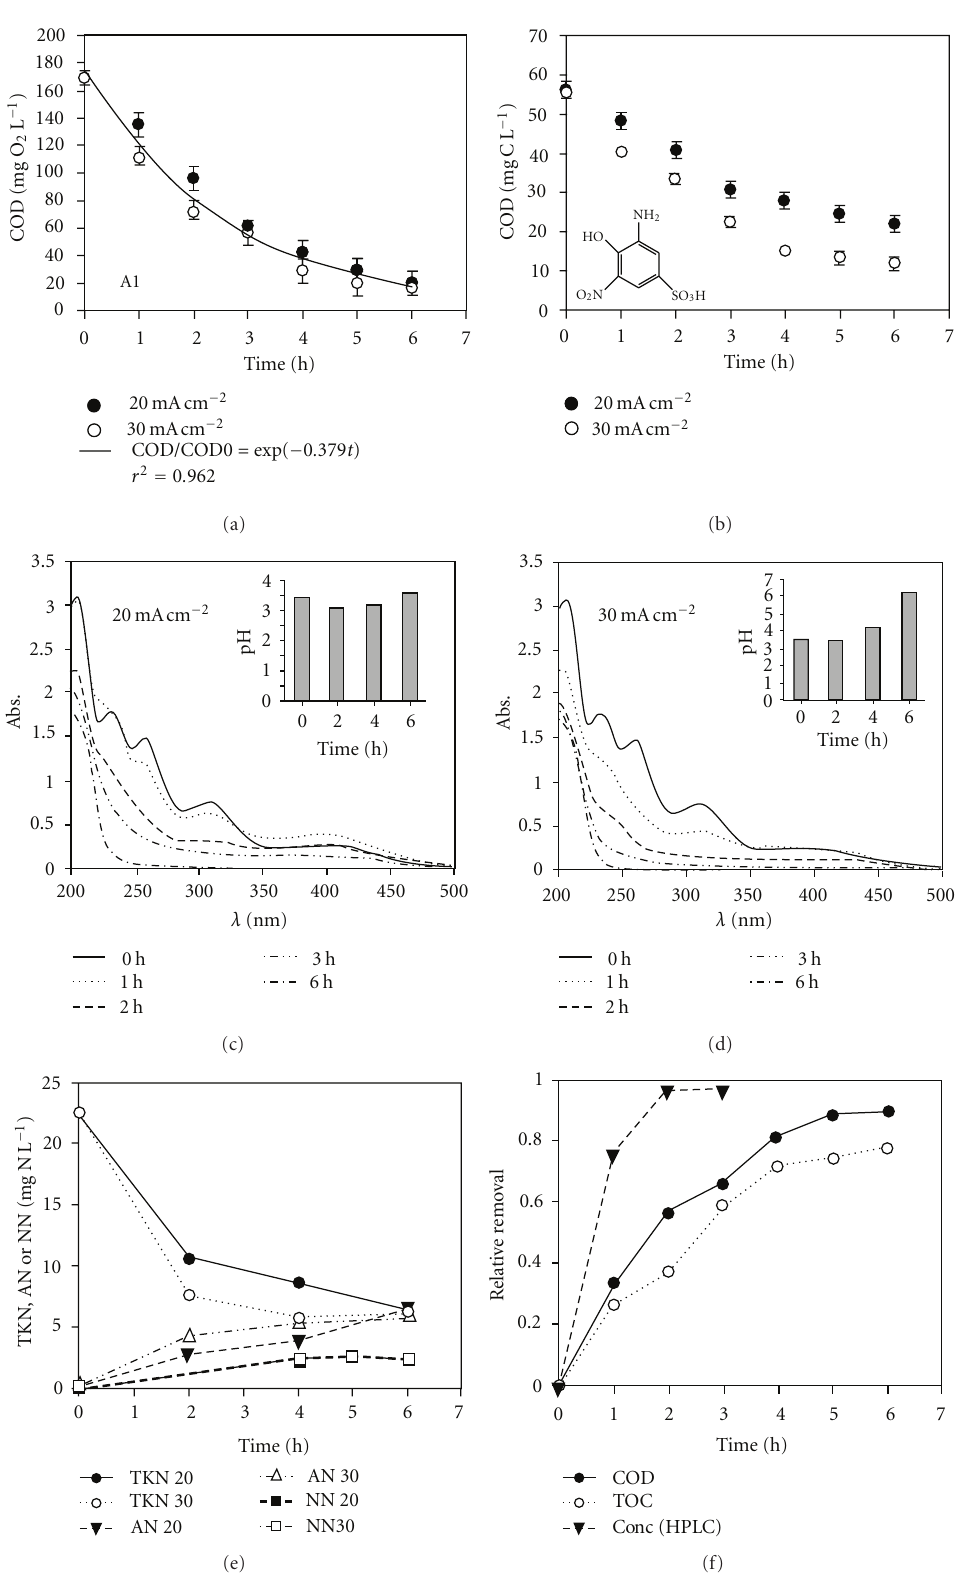
Figure 8: Variations of COD (a), TOC (b), absorbance and pH (c, d), TKN, AN and NN (e) and relative removals of COD, TOC and concentration (f) versus. time observed during the degradation assays of the amine A1, with an initial concentration of 200 mgL − 1 , performed with a BDD anode (8cm 2 ). Cathode: stainless steel (8cm 2 ); current density: 20 and 30 mAcm − 2 ; electrolyte 0.035 M Na 2 SO 4 aqueous solution